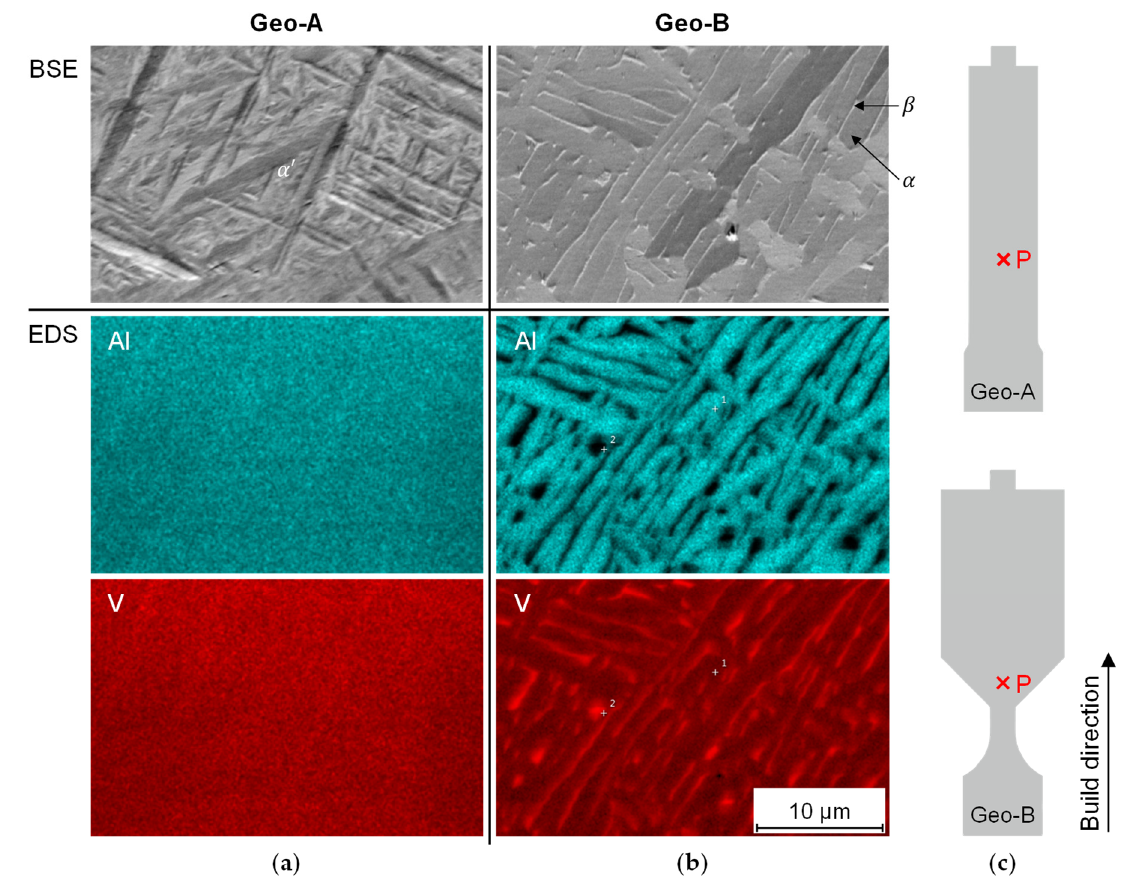
Figure 6. SEM images acquired in BSE mode and EDS element mapping of Al and V at evaluation point P for ( a ) Geo-A showing the martensitic 𝛼′ microstructure and ( b ) Geo-B showing 𝛼 + 𝛽 microstructure, ( c ) Geometry variants Geo-A and Geo-B with evaluation point P marked.